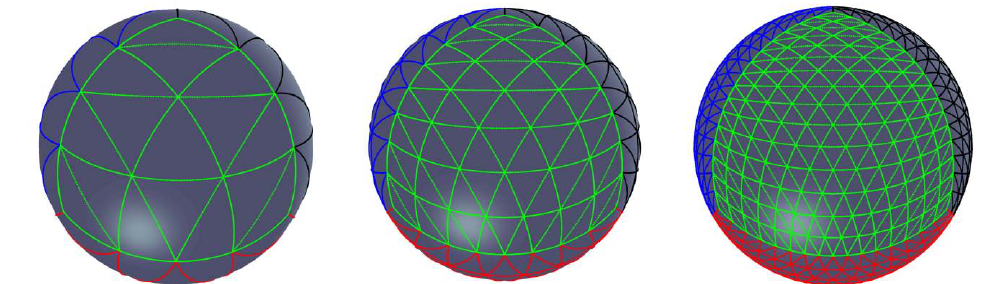
Figure 10. The 4-fold tetrahedron version Discrete Global Grid Systems (DGGSs) based on SACs (level = 2, 3, 4).